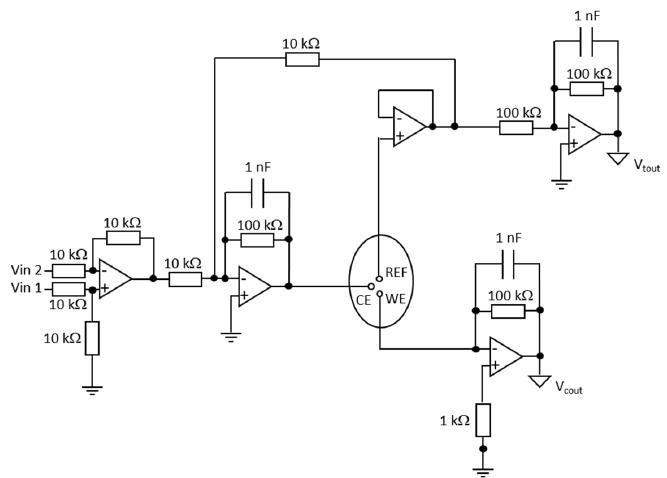
Figure 5. Schematic organization of components of the conditioning card.